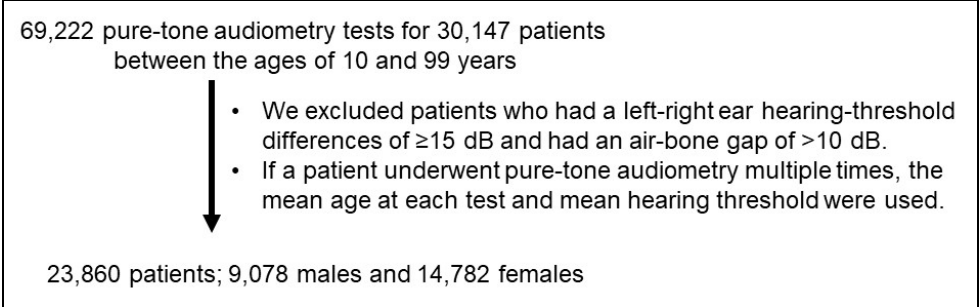
Figure 1. Study design and the number of subjects.